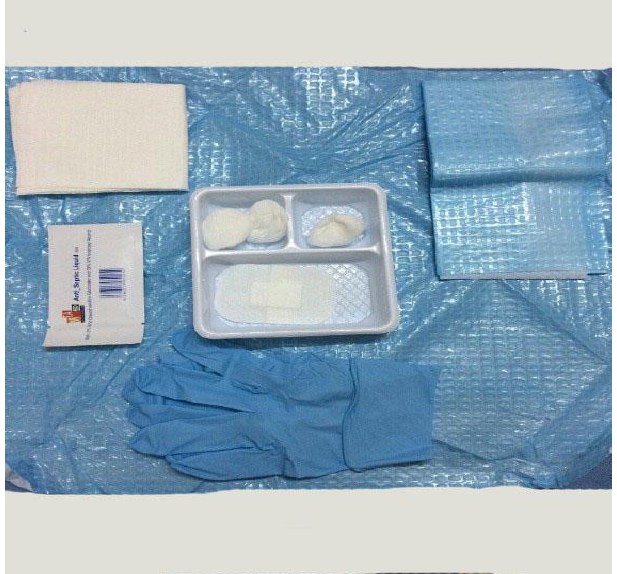
Figure 1.Sterile kit for injection Procedure Description;- patient is supine with the knee extended on the couch . from the lateral side The synovial